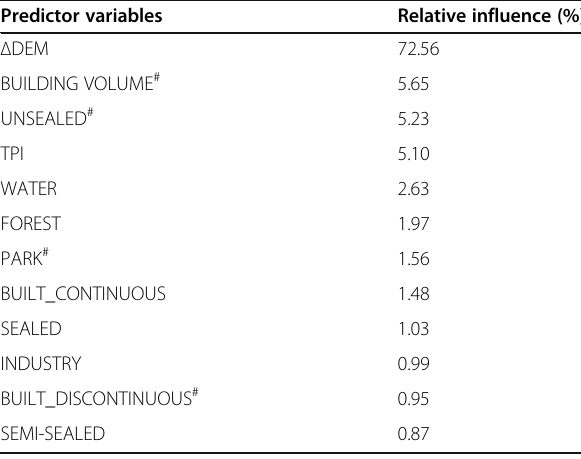
Table 2 Relative influence of predictor variables (variables used to define/modify scenarios are marked with # ) Predictor